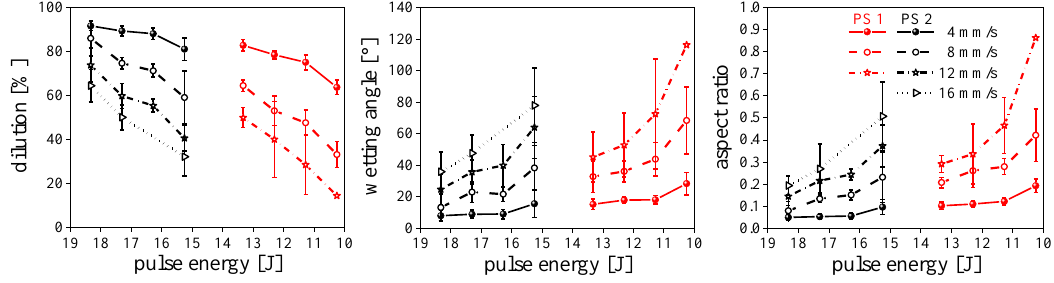
Figure 15. Hot-wire power averaged objectives as function of the pulse energy for the applied wire-feeding rates and pulse shapes (PS). The legend of aspect ratio is general for all objectives.